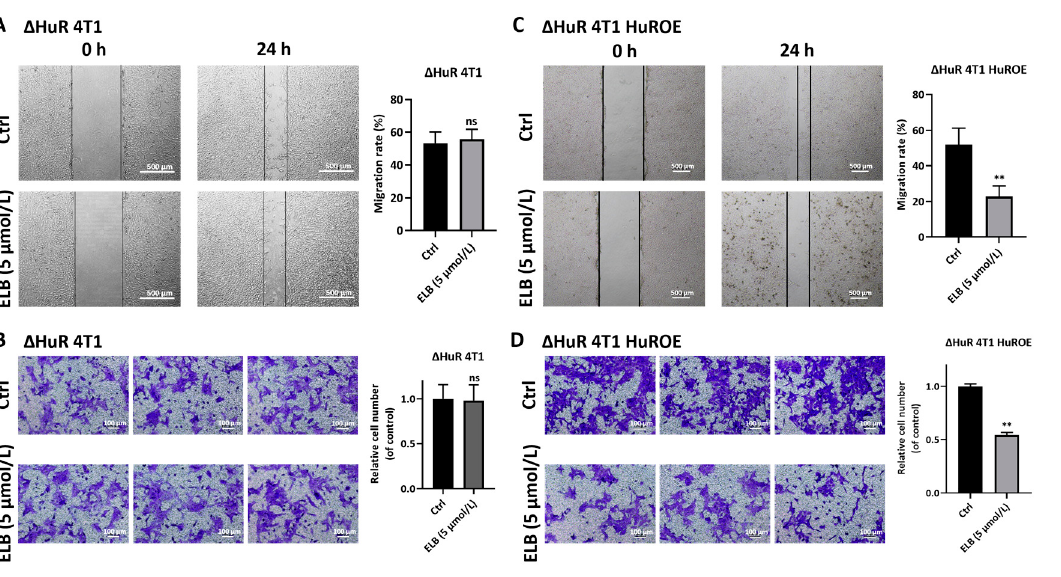
Figure 2. The role of eltrombopag in migratory and invasive of 4T1 cells. ( A ) Impact of eltrombopag to expression of E-cadherin protein in 4T1 cells, representative images and quantitative data of im- munofluorescence experiments are shown (Scale bar: 100 μ m). ( B ) Impact of eltrombopag to expres- sion of vimentin protein in 4T1 cells, representative images and quantitative data of immunofluo- rescence experiments are shown (Scale bar: 100 μ m). ( C ) Scratch wound assay was used to deter- mine the migration effect of eltrombopag on 4T1 cells, representative images and quantitative data are shown (Scale bar: 500 μ m). ( D ) Transwell migration experiment was used to determine the ver- tical migration effect of eltrombopag on 4T1 cells, representative images and quantitative data are shown (Scale bar: 100 µ m). ( E ) Transwell invasion assay was used to investigate the inhibitory effect of eltrombopag on the invasion of 4T1 cells, representative images and quantitative analyses are shown (Scale bar: 100 μ m). Mean ± SD. n = 3. ** p < 0.01 vs. control group ( t -test).